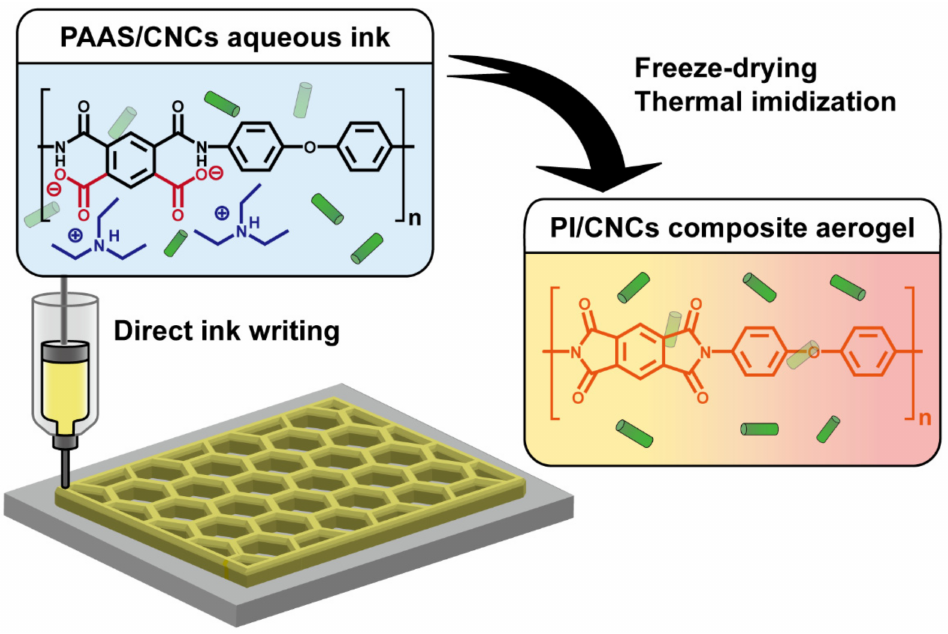
Figure 1. Synthesis and 3D printing of PI/CNC composite